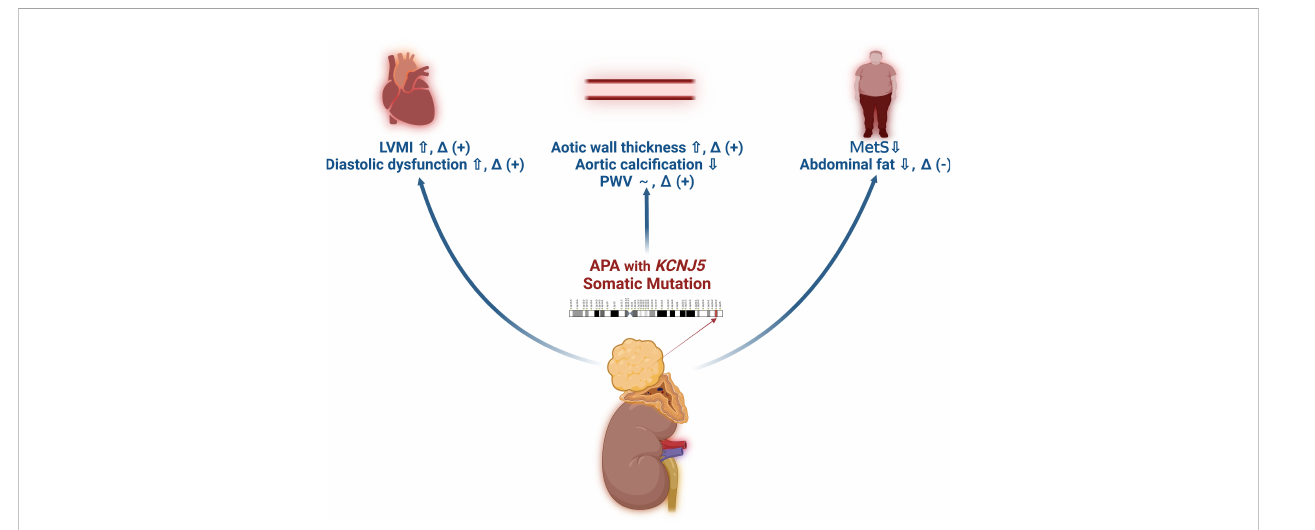
FIGURE 2 The schematic diagram of the effect of KCNJ5 somatic mutations on target organ damage in patients with aldosterone producing adenoma. *~: similar results between patients with or without KCNJ5 somatic mutations. * D (+): Improvement after adrenalectomy. * D (-): Deterioration after